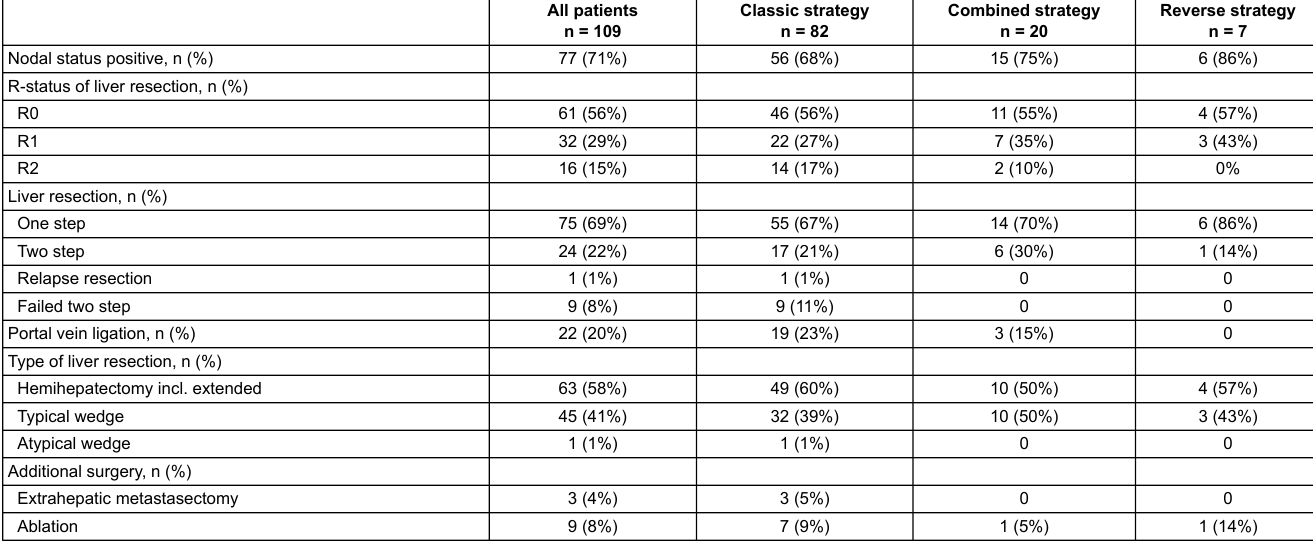
Table 2: Intraoperative parameters and histological